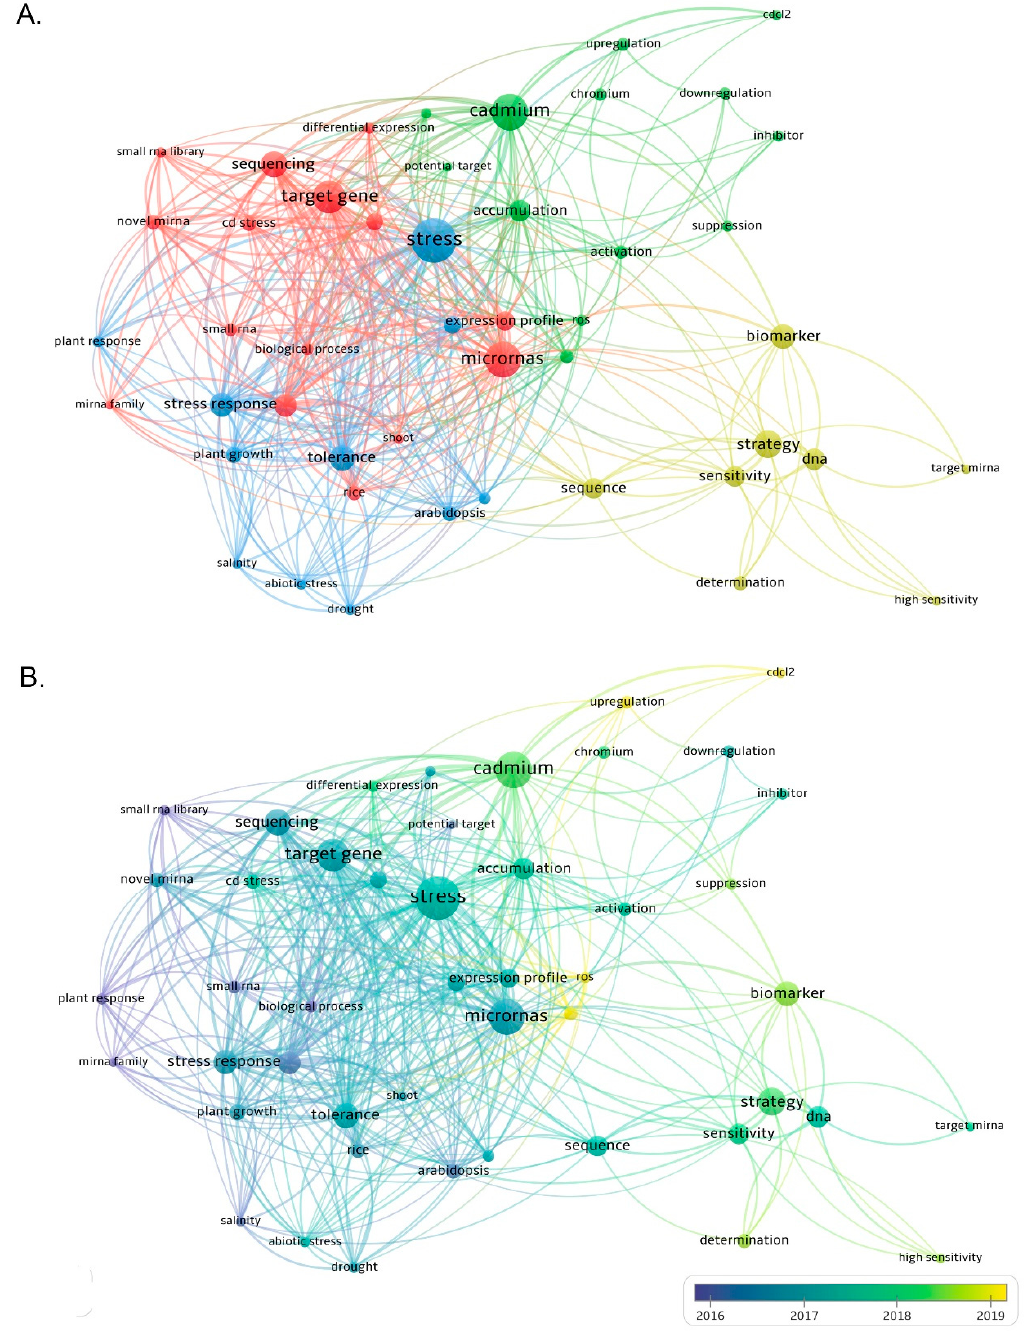
Figure 1. Keyword co-occurrence graph analysis using VOSviewer software. ( A ) A total of 568 rele- vant articles were searched from academic papers over the past 10 years using the keywords miRNA, Cu, Cd, Hg, Al, As and Cr, four research centers focusing on miRNA, stress, cadmium, and strategy were formed. ( B ) Different colors correspond to the year in which the keywords appeared on average, and keywords with blue color presented earlier than those with yellow.